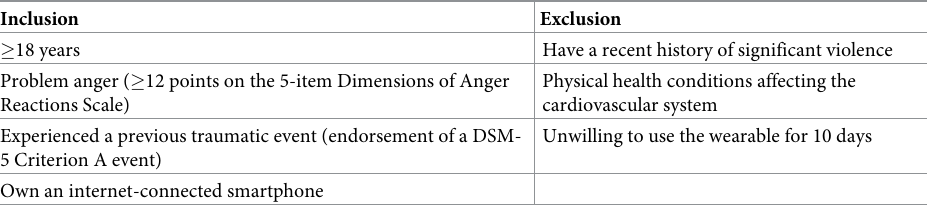
Table 1. Study inclusion and exclusion